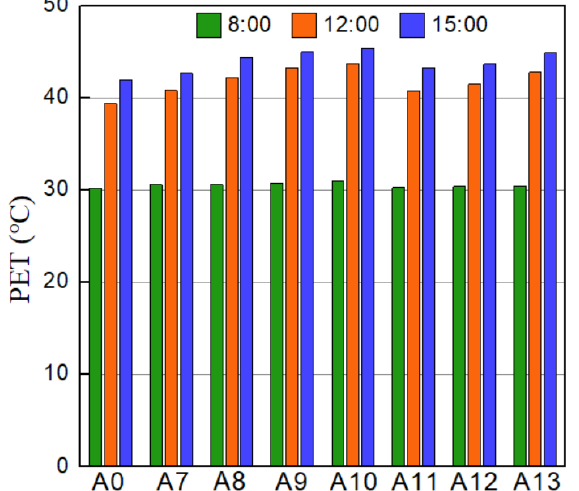
Figure 18. PET of the base case and cases with different surface albedo values at 8:00, 12:00, and 15:00.